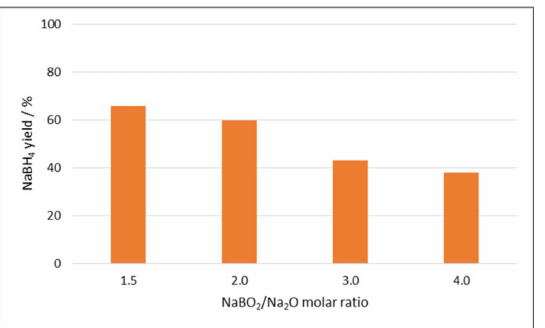
Figure 7. Values of NaBH 4 yield vs. NaBO 2 /Na 2 O molar ratio. Adapted from